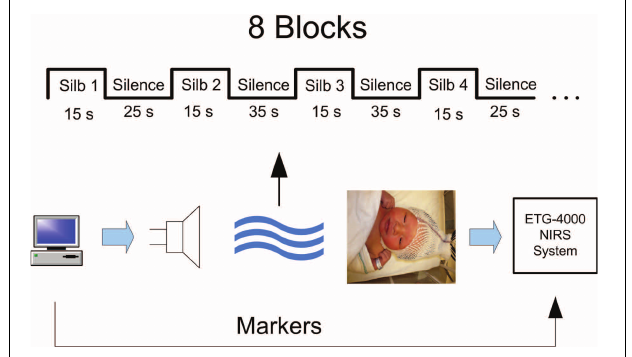
FIGURE 1 | fNIRS experiment